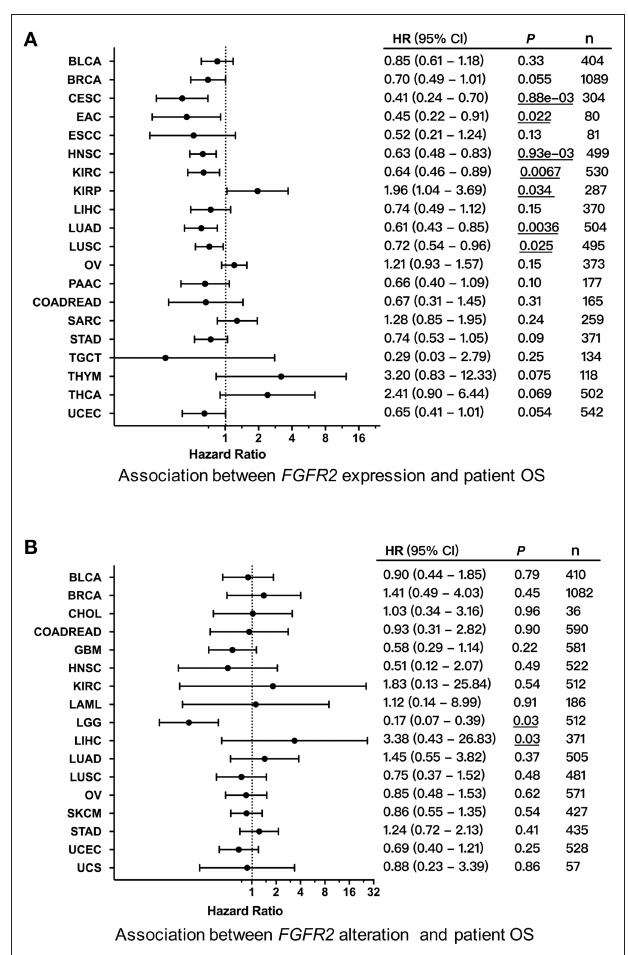
FIGURE 8 | Association between FGFR2 alterations and patient survival. (A) Forest plot for the association between FGFR2 expression and patient overall survival (OS). (B) Forest plot for the association between FGFR2 alterations and patient OS. These significant P -values are